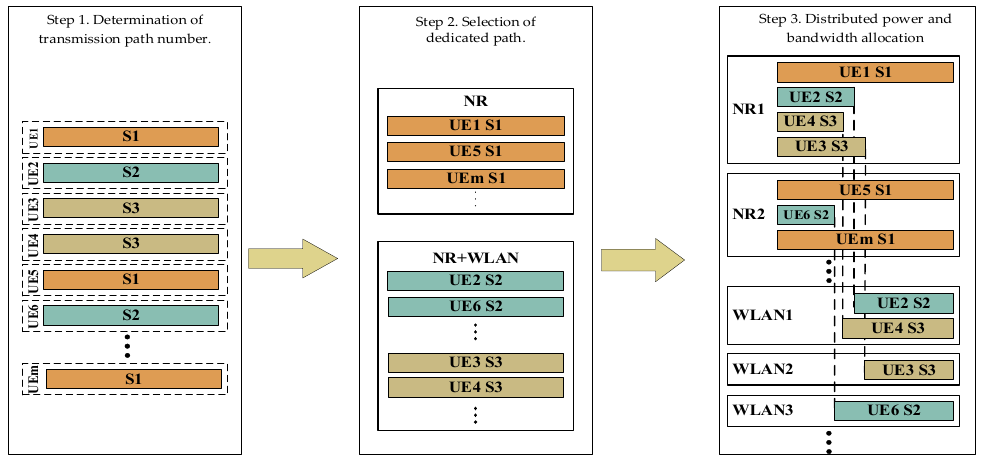
Figure 3. Multiservice traffic scheduling model.